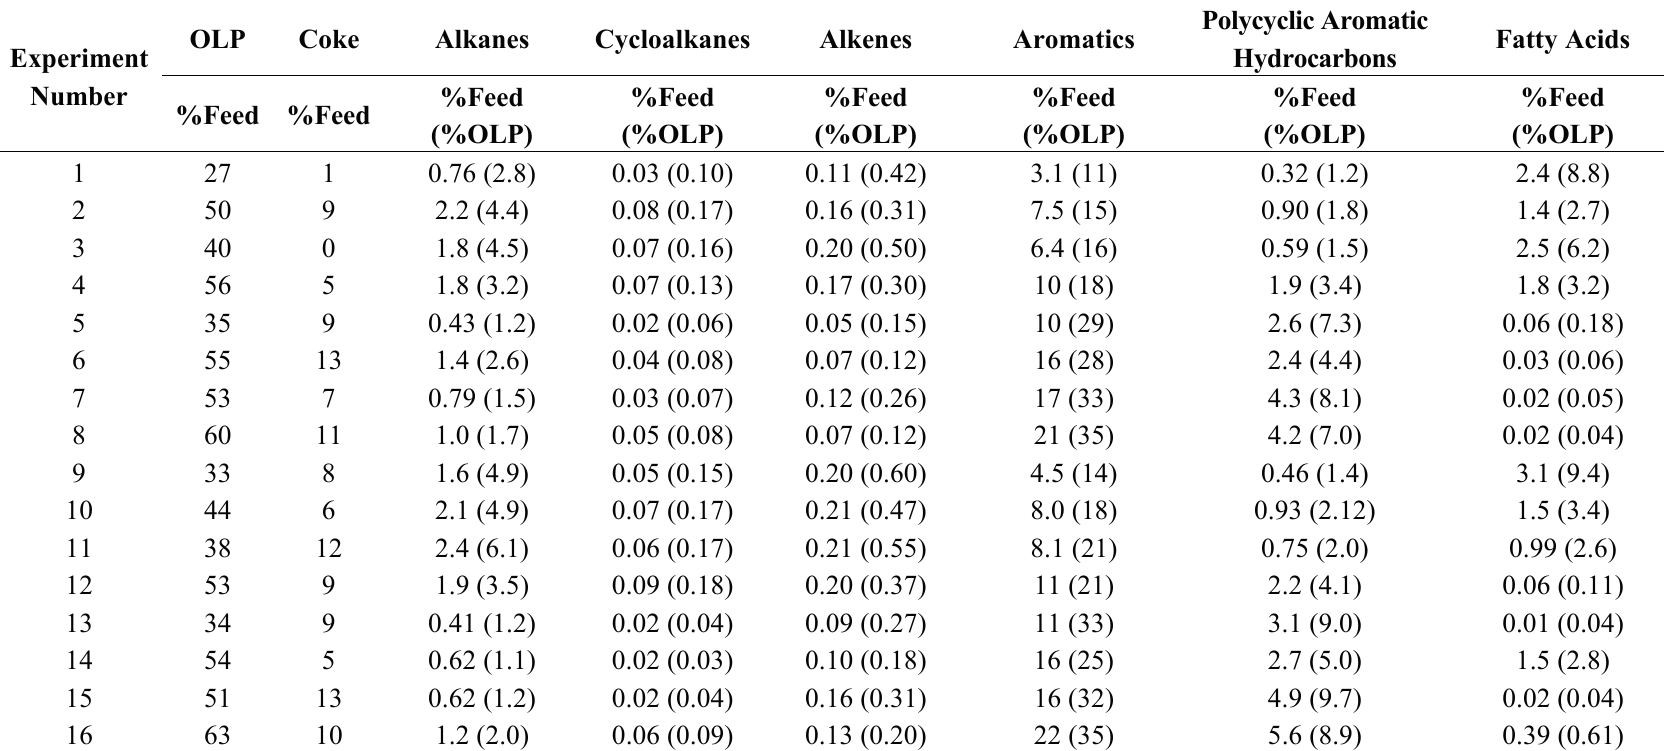
Table 3. Composition results from the catalytic cracking of soybean oil (concentration reported as weight percent based on feed oil and the organic liquid product